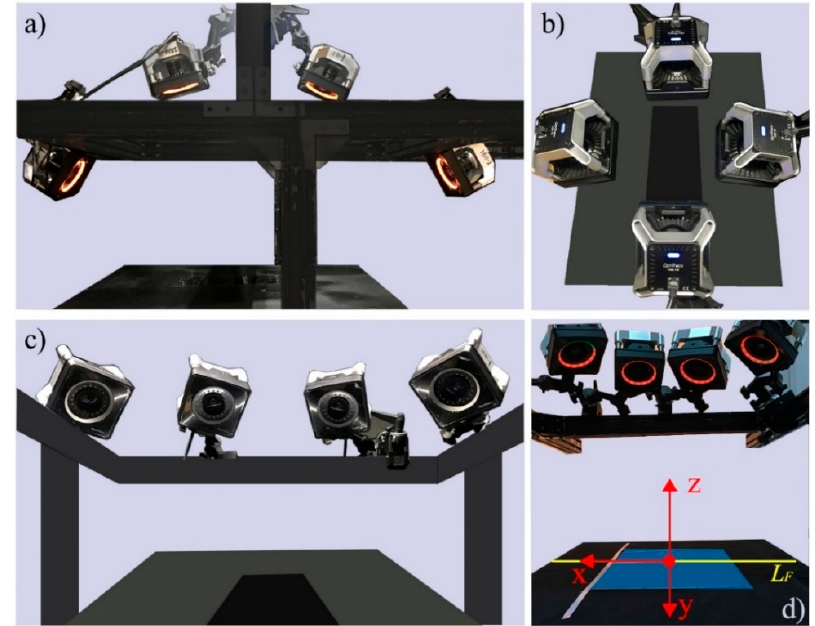
Figure 6. Typical layouts diagram of a multi-camera unit modular ( a ) Arched layout; ( b ) Annular layout; ( c ) Half-annular layout; ( d ) A multi-camera motion-capture platform in a half-annular layout (pitch angle of 60°) with its coordinates to the middle point of the alignment line ( L F ).